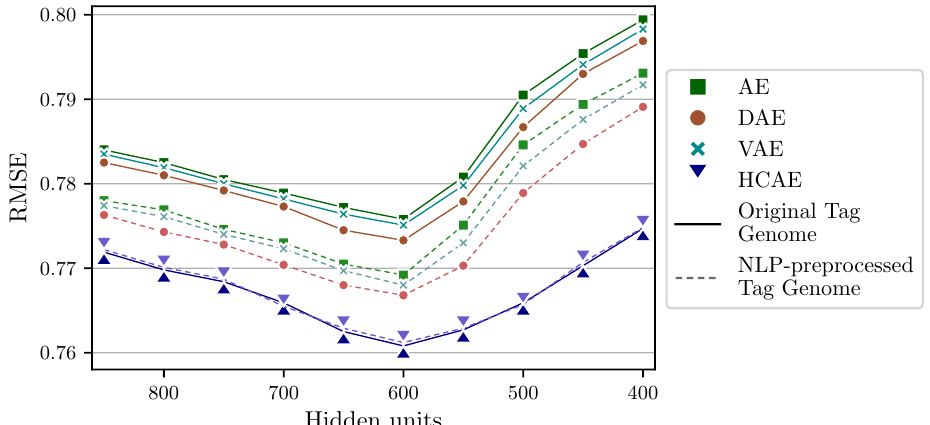
Figure 4. Error rates of kNN-Content models using HCAE and the variants of AE with respect to the size of the Compression